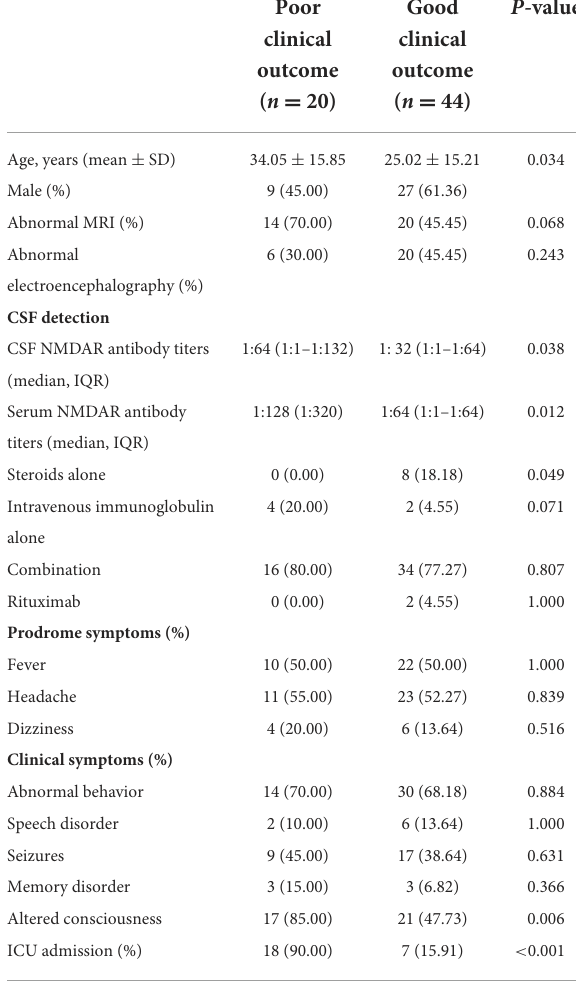
TABLE 3 The clinical characteristic and autoantibodies between a poor clinical outcome and a good clinical outcome at 12 months in anti-NMDAR